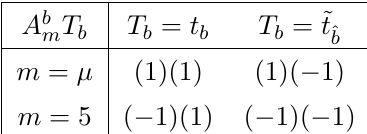
Table 1 . Eigenvalues of A b under ( P )( P 5 ) respectively for each component. The components m A b ; A ^ b have a combined +1 eigenvalue and hence have massless modes. (cid:22) 5